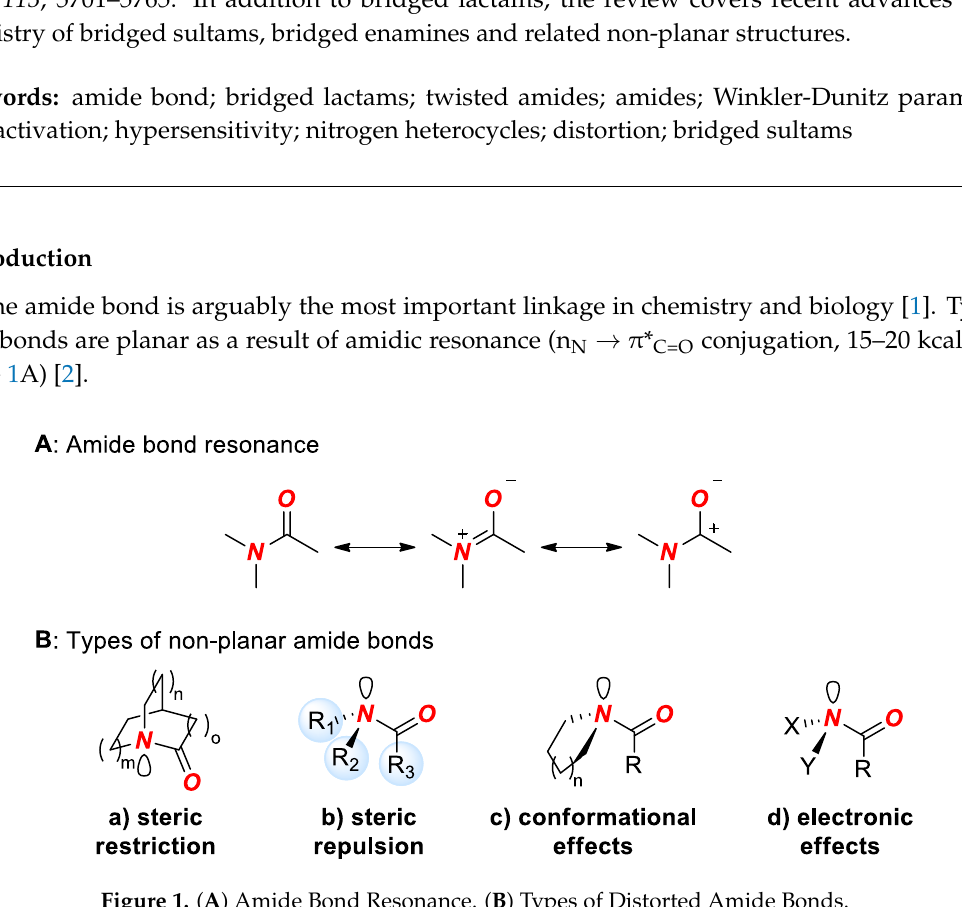
Figure 1. ( A ) Amide Bond Resonance. ( B ) Types of Distorted Amide Bonds.